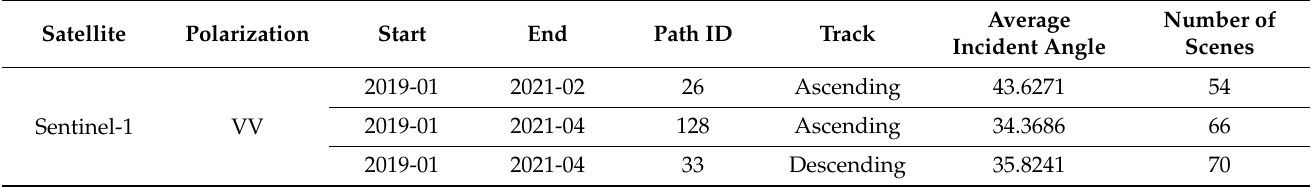
Table 1. Sentinel-1 image